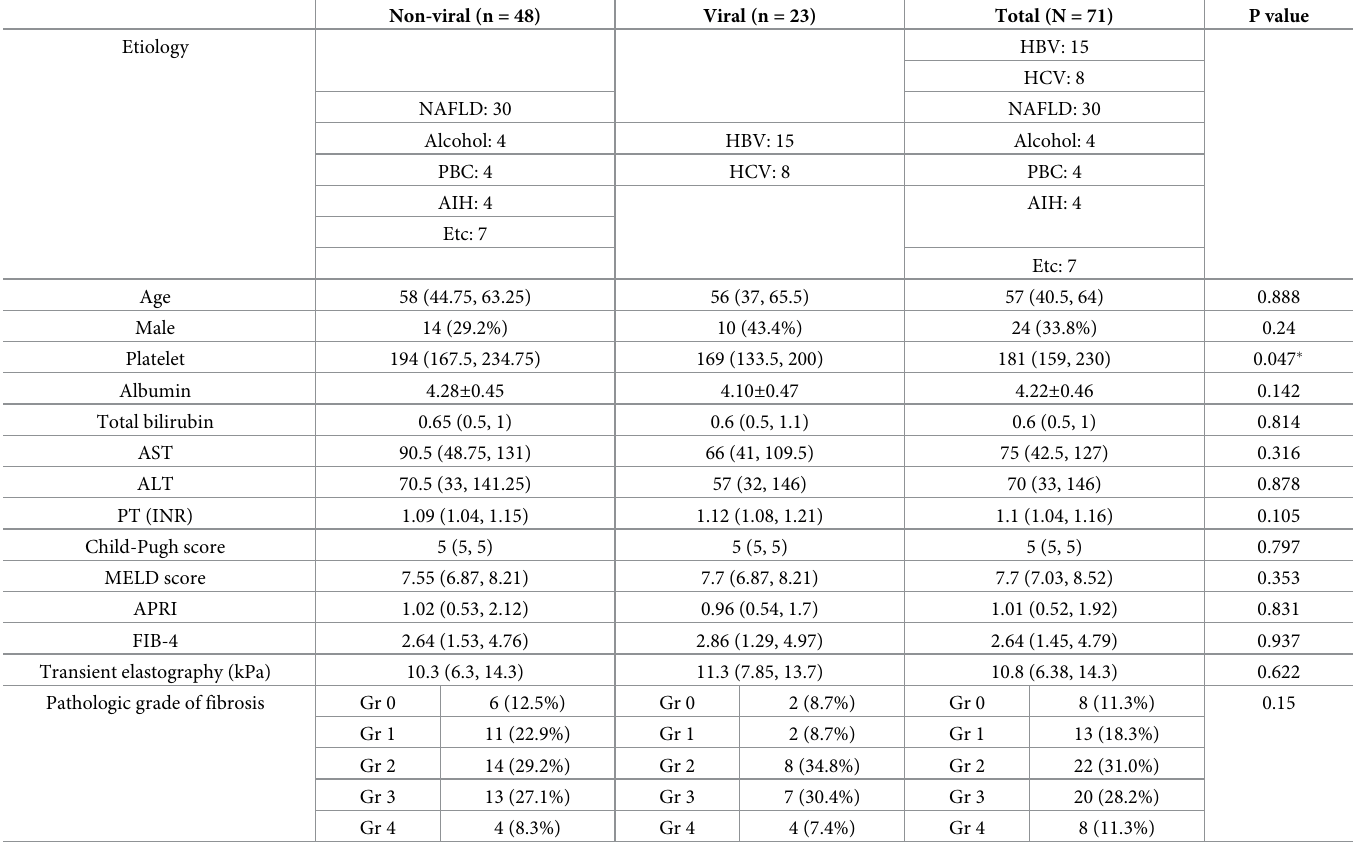
Table 1. The baseline characteristics of the study